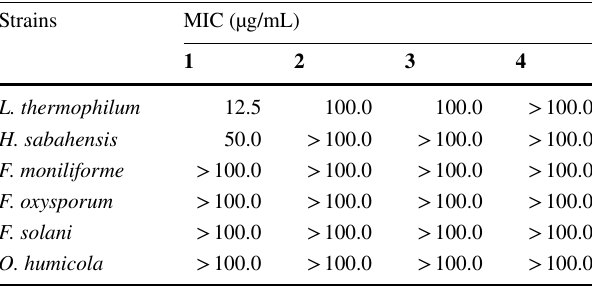
Positive control: itraconazole MIC 2.0 µg mL